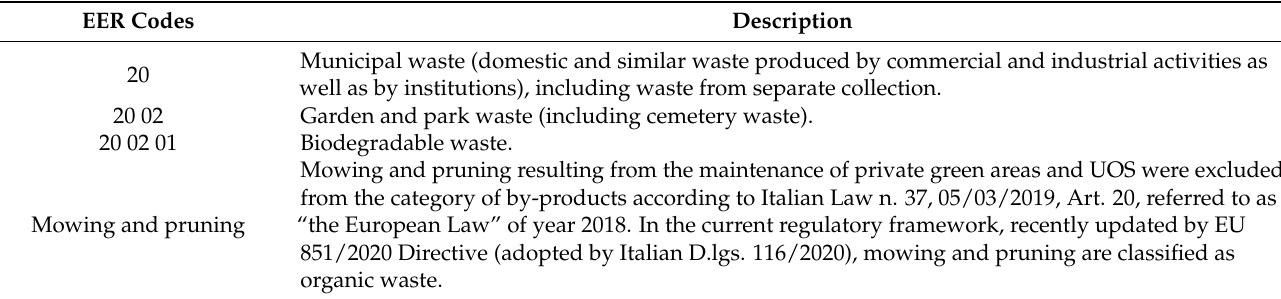
Table 10. EER codes for waste from park and garden maintenance. EER Codes